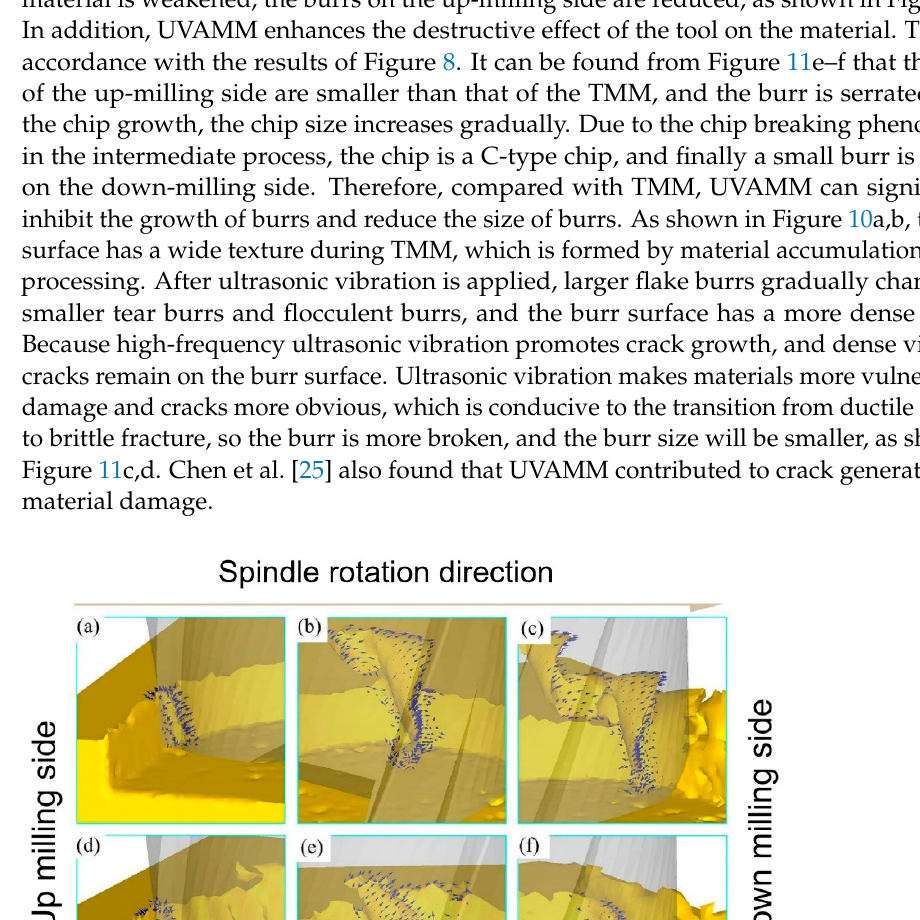
Figure 11. Burr morphology ( a , b ) TMM; ( c , d ) UVAMM. (2) Effect of ultrasonic vibration on burr formation at different V c . Figure 12 shows the burr morphology generated by simulating TMM and UVAMM with different V c ( f z = 6 μ m/z, a p = 50 μ m). It can be seen from Figure 12 that when the V c is 37.7 m/min, large flake burrs are produced on the top of the groove. With the increasing of the V c , the burr size first decreases and then increases without ultrasonic vibration. When vibration is applied, the flake burrs gradually change to tearing burrs, and the size and quantity of burrs reduce. When the A is 6 μ m, the size and quantity of burrs are the smallest. In addition, ultrasonic vibration has the most obvious effect on milling at medium and low cutting speed. Zhang et al. [31] also pointed out that the burrs become